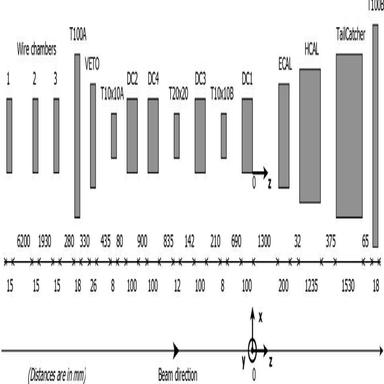
Plan view of the beam line at FNAL. Distances (not to scale) are in mm.